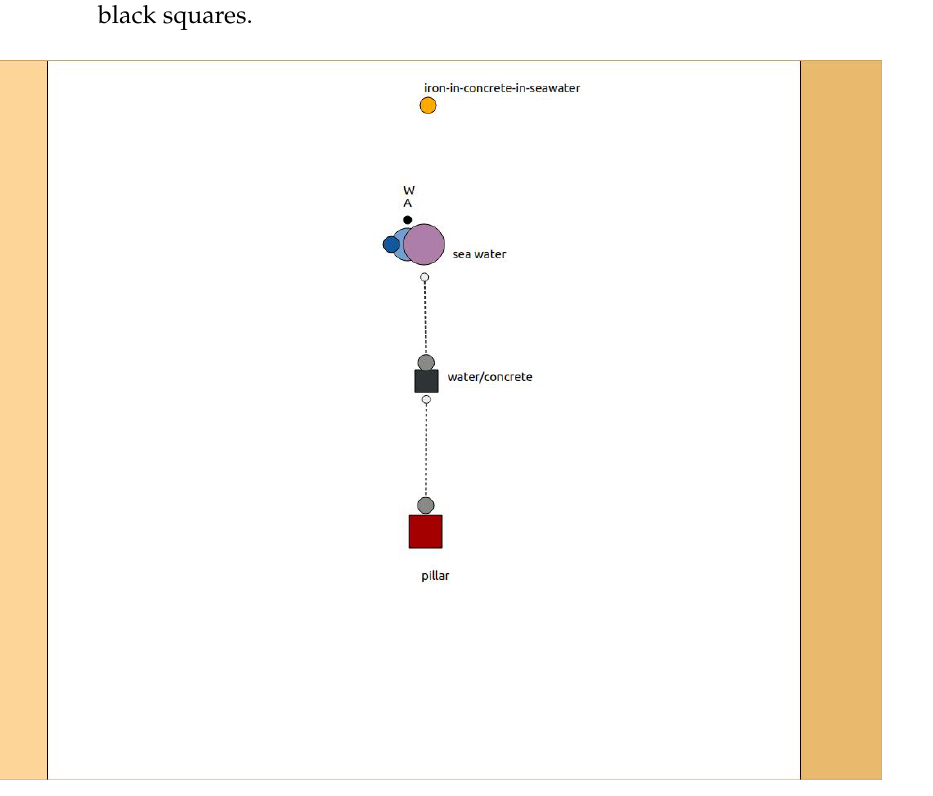
Figure 13. Rusting iron in concrete, a view of the ProMo’s graphical modeller showing the top of the hierarchy with the pillar in the seawater. The seawater is modelled as a reservoir system (large mauve circle) with two circular indicators attached, as seawater is a liquid. The black dot indicates mass, and the ”W” and “A” stand for the species water and active